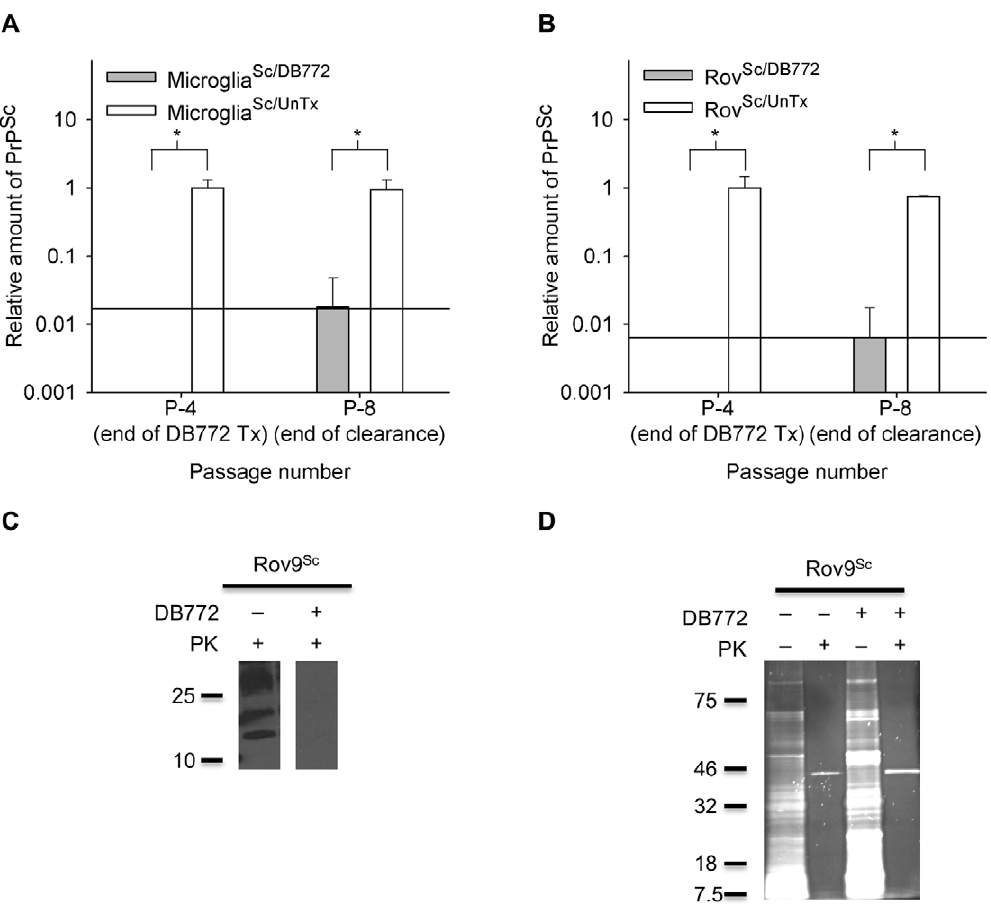
Figure 3. DB772 inhibits PrP Sc accumulation in primary sheep microglial cells and Rov9 cells. Determination of PrP Sc levels in sheep microglial cells (A) and Rov9 cells (B). Cells were inoculated with PrP Sc , and following establishment of PrP Sc accumulation, treatment groups were maintained in culture with 4 m M of DB772 for four passages. At the fourth passage (P-4, end of DB772 Tx), an aliquot of cells was lysed for PrP Sc ELISA. All cultures were then continued for another four passages without DB772. Cells were collected for PrP Sc ELISA at the end of those four passages (P-8, end of clearance). A standard curve was used to transform the corrected optical densities into relative concentration of PrP Sc . Data columns represent the means 6 one standard deviation. Results at each passage were statistically compared between DB772-treated and untreated groups. The y-axis reference line indicates the minimum detection limit of the ELISA. *, P , 0.05. Positive and negative ELISA results were compared to proteinase K digestion-based immunoblotting (C). Passage 5 Rov9 Sc/UnTx and Rov9 Sc/DB772 samples were lysed, treated with 50 m g/ml of proteinase K, precipitated with phosphotungstic acid, and immunoblotted using the monoclonal anti-PrP antibody F99/97.6.1. Proteinase K-resistant prion protein bands were detected in P-5 Rov9 Sc/UnTx samples, whereas bands were not detected in the P-5 Rov9 Sc/DB772 lysates, consistent with the ELISA results. Successful precipitation of protein via the phosphotungstic acid method was confirmed in Rov9 Sc/DB772 and Rov9 Sc/UnTx samples, with most protein being proteinase K susceptible (D). The positions of molecular mass standards (in kilodaltons) are indicated to the left of the immunoblot (C) and gel (D). (Table 2) the dynamic range for anti-pestiviral activity was determined to be 0.004–0.04 m M in microglia Sc and 0.0004– 0.004 m M in Rov Sc , whereas the dynamic range for PrP Sc inhibition in microglia Sc and in Rov Sc was 0.4–4.0 m M (Table 2).